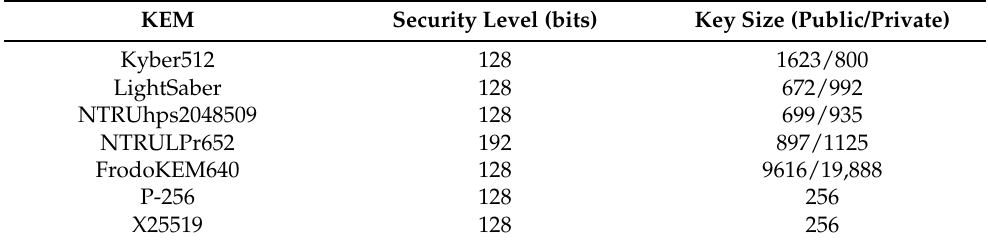
Table 11. Summary of the theoretical aspects of the key exchange mechanisms considered so far, including key size and security level in bits. Recall that all have IND-CCA2 theoretical strength. KEM Security Level (bits) Key Size (Public/Private)